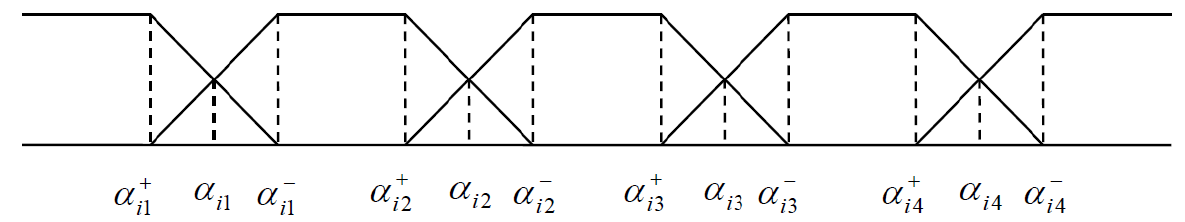
Figure 2. Diagram of decreasing type membership